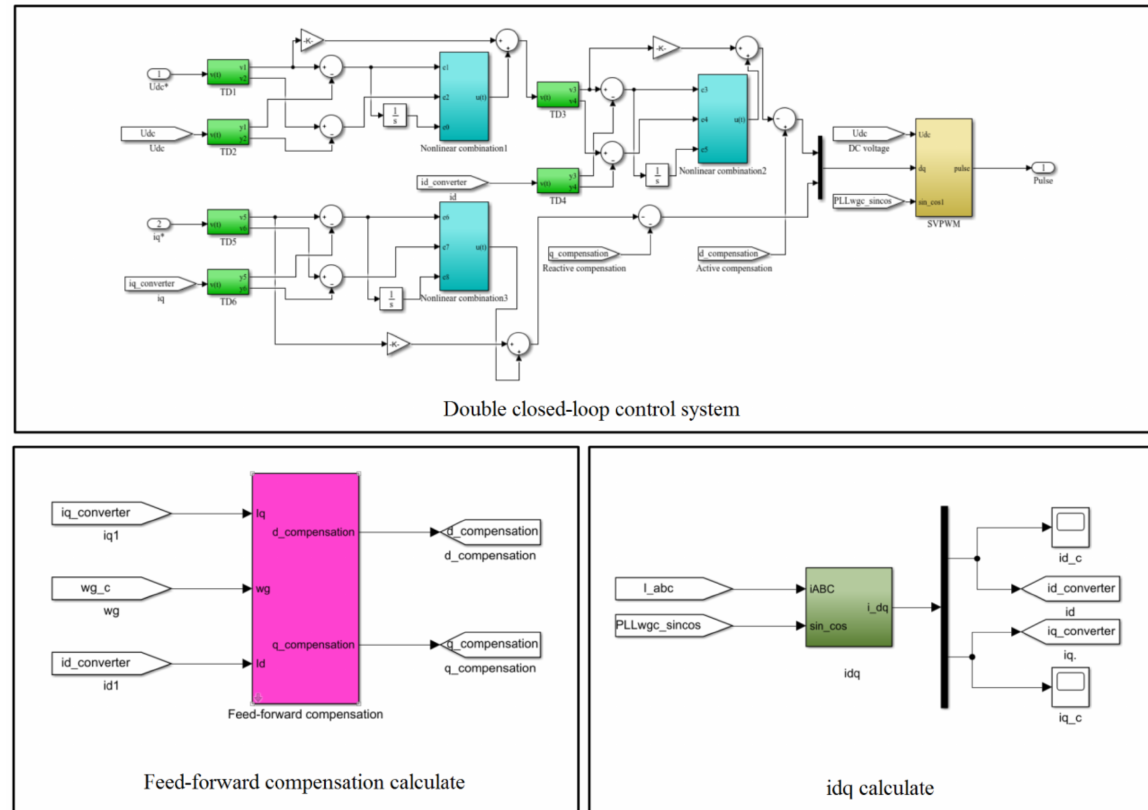
Figure 6. Simulation model of double closed-loop control system based on nonlinear feed-forward PID control.